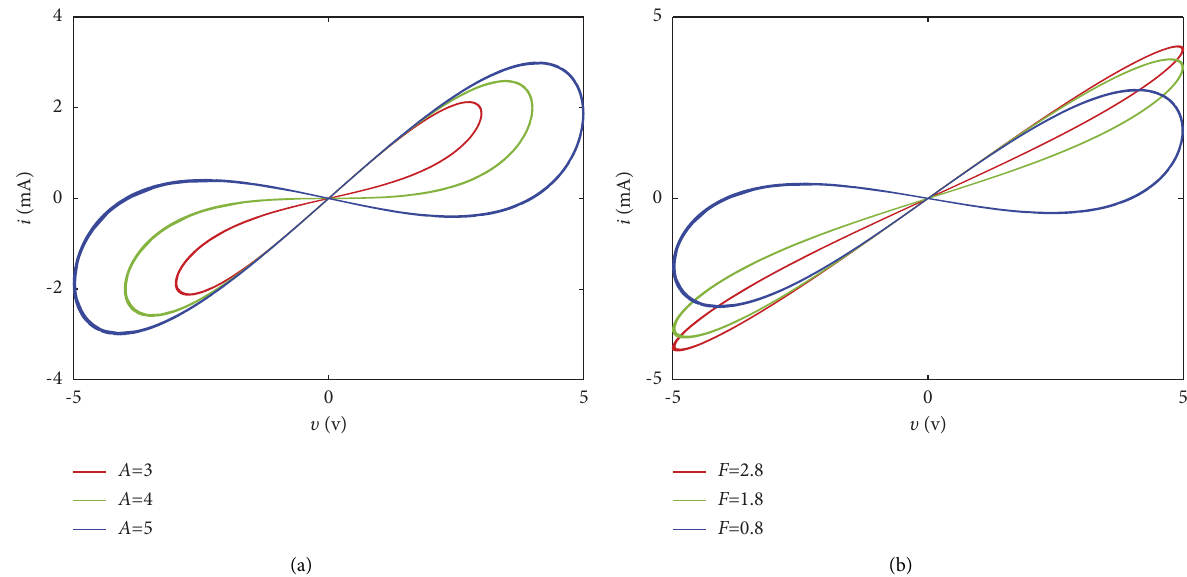
Figure 3: Numerical simulation of absolute memristor tight hysteresis loop. (a) Diferent amplitude A values; (b) diferent frequency F